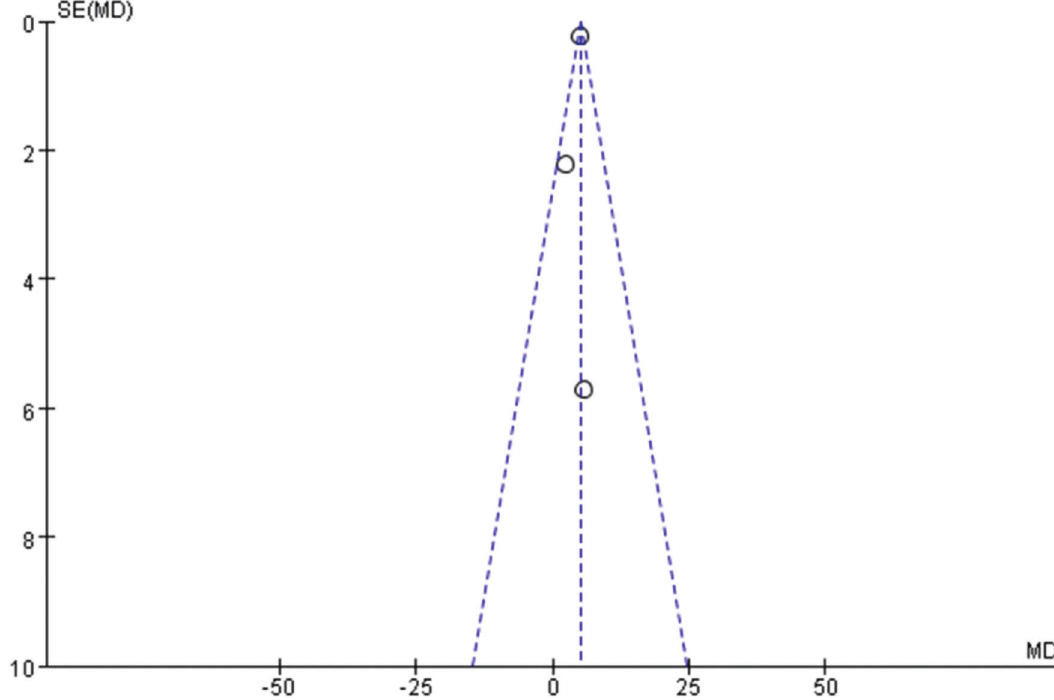
Figure 5 - Funnel chart of the relationship between interleukin-6 and the risk of major adverse cardiovascular events during acute coronary syndrome follow-up. SE, standard error; MD, mean